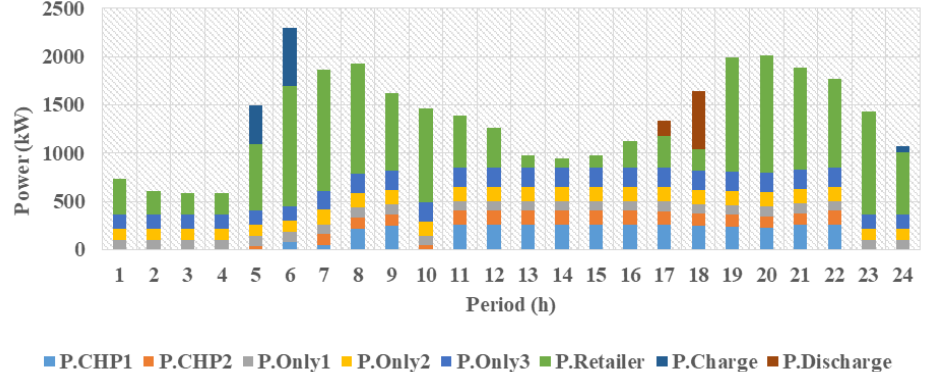
Figure 10. Share of supplying electrical power in a 10% demand response.